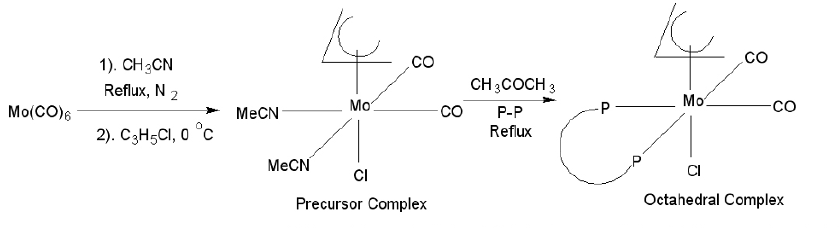
Figure 1. Reaction